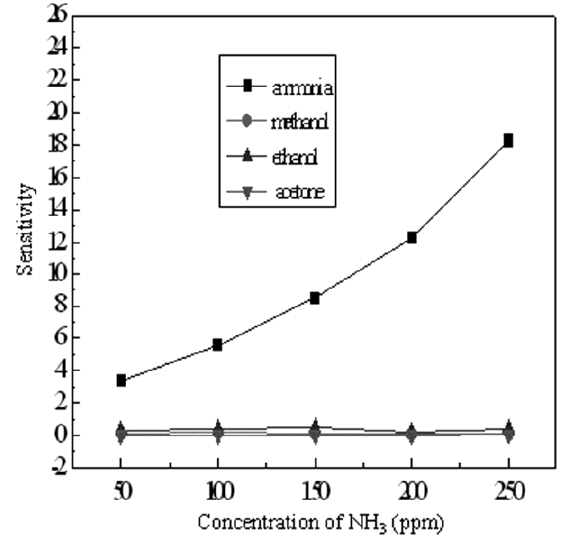
-PANI/PA6 to ammonia, methanol, ethanol and 2